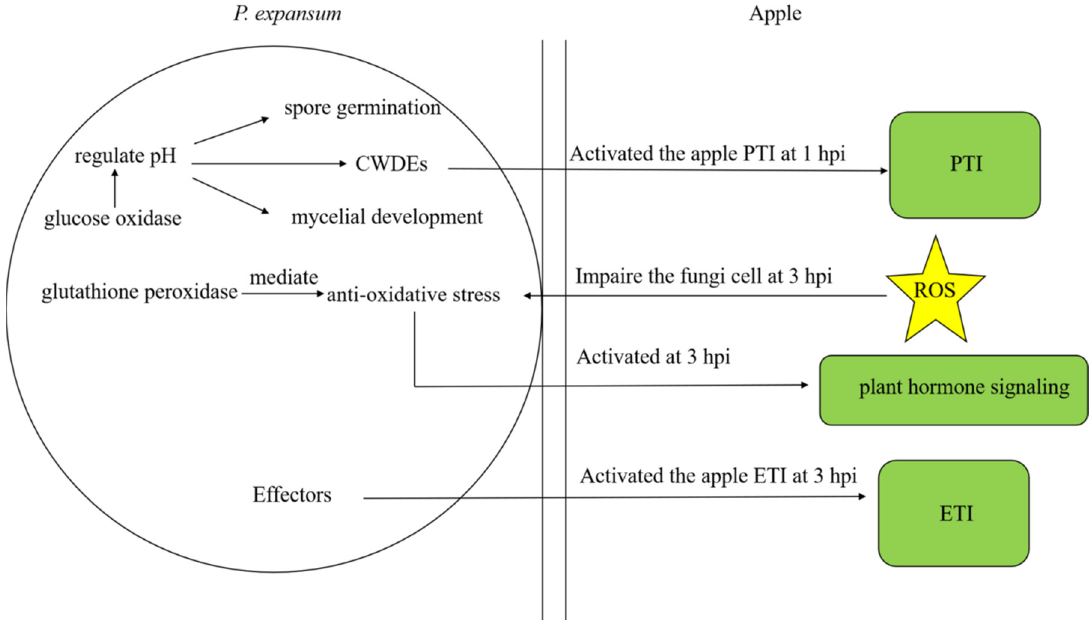
Figure 6. The interaction analysis between P. expansum and wounded, inoculated apple fruit tissues. Glucose oxidase expression by P. expansum altered the pH of the micro-environment, providing an optimum pH for spore germination, mycelial development, and cell wall degrading enzyme (CWDE) activity. CWDEs expressed by P. expansum activated (PAMP)-triggered immunity (PTI) in apple at 1 hpi. Apple tissues generated an accumulation of ROS to impair pathogen cells at the swelled spore stage (3 hpi) of P. expansum . The expression of glutathione peroxidase was induced in P. expansum to mediate oxidative stress. PTI was activated in apple at the spore activation stage (1 hpi), then effector-triggered immunity (ETI) and plant hormone signaling were activated at the swelled spore stage (3 hpi) in response to the presence of P. expansum .